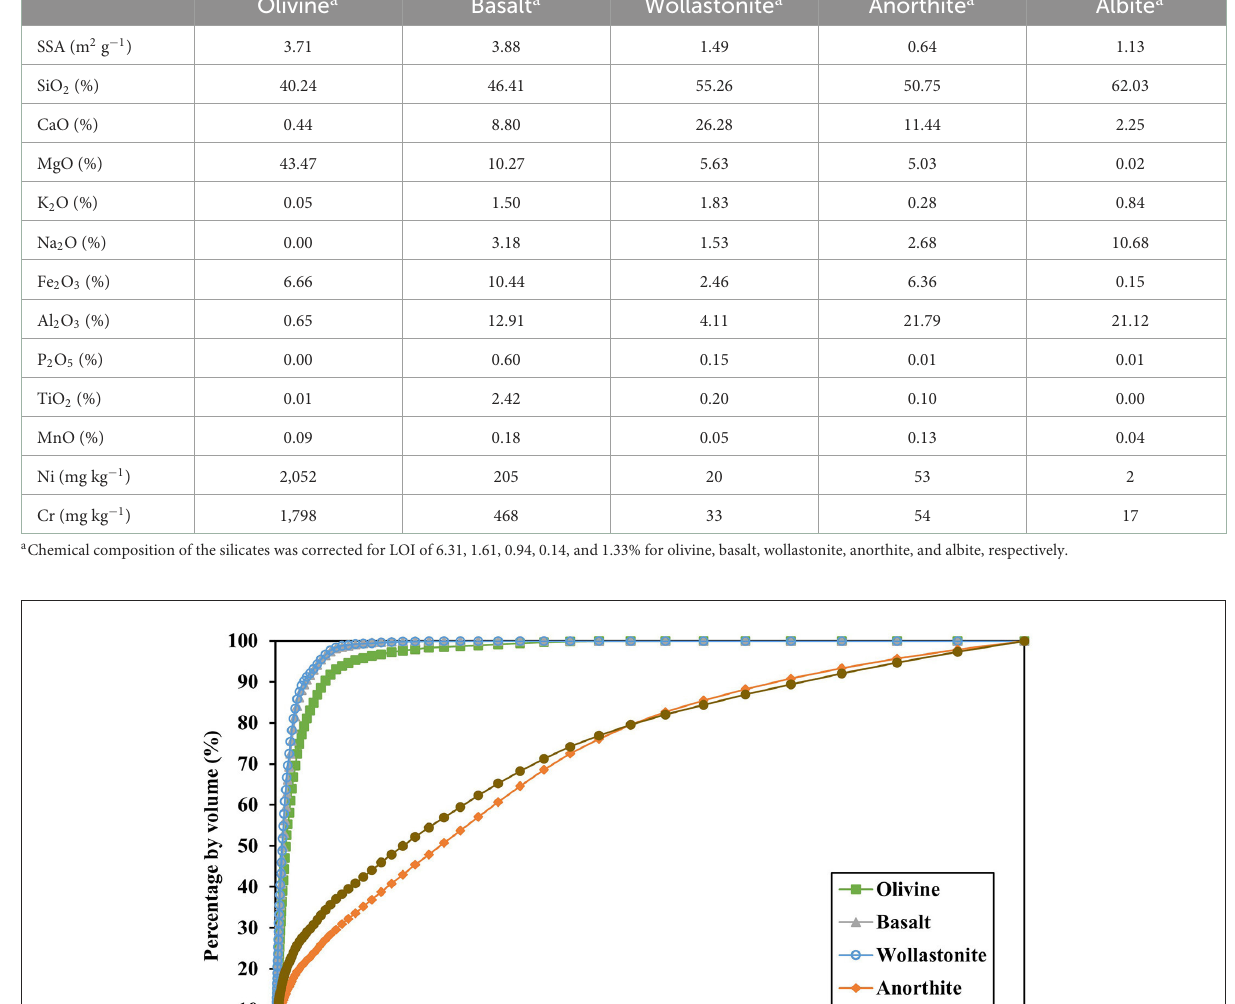
TABLE 2 Specific Surface Area (SSA) and chemical composition of the silicate minerals and basalt used in this experiment. Olivine a Basalt a Wollastonite a Anorthite a